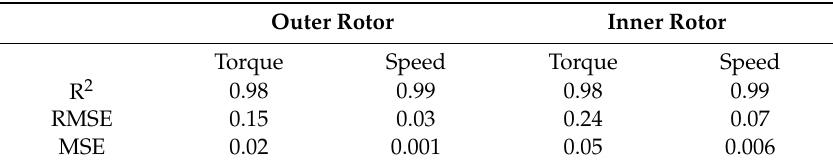
Table 5. Statistical performance analysis results, LPF-based case study.